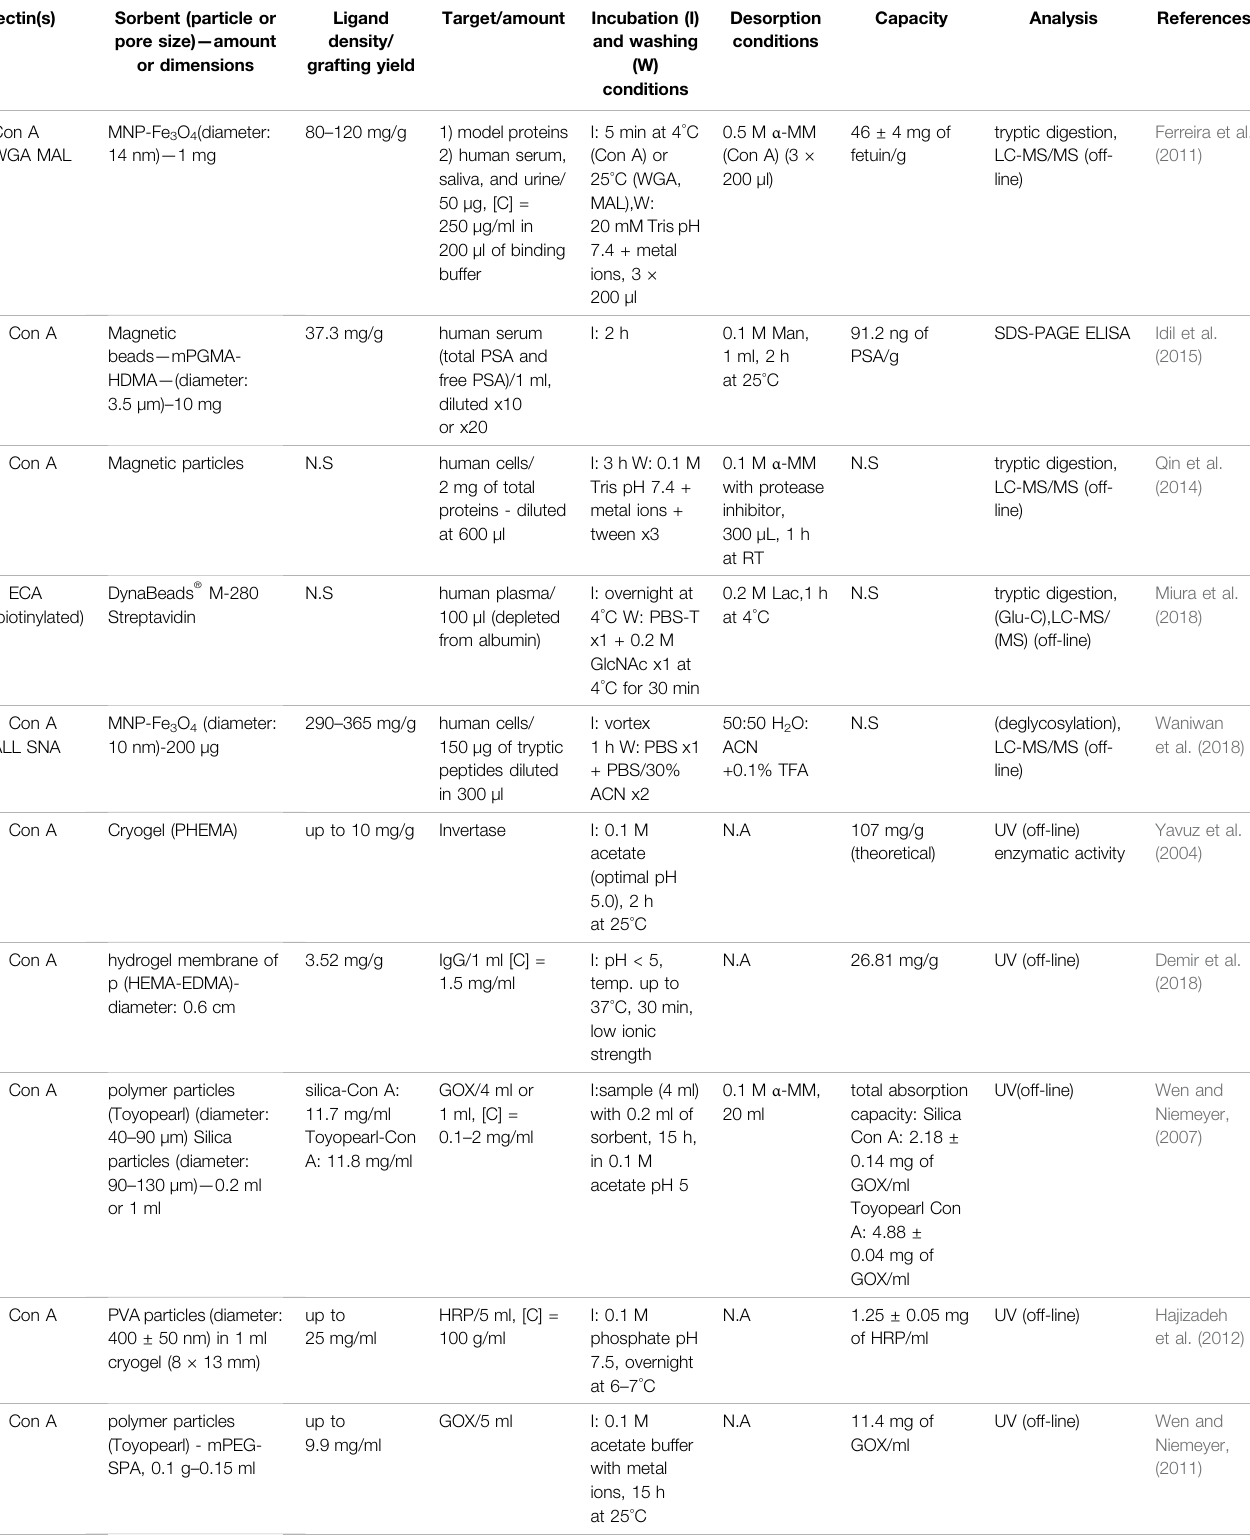
TABLE 5 | Lectin dispersive solid phase extraction using home-made sorbents. lectin(s) Sorbent (particle or pore size) —